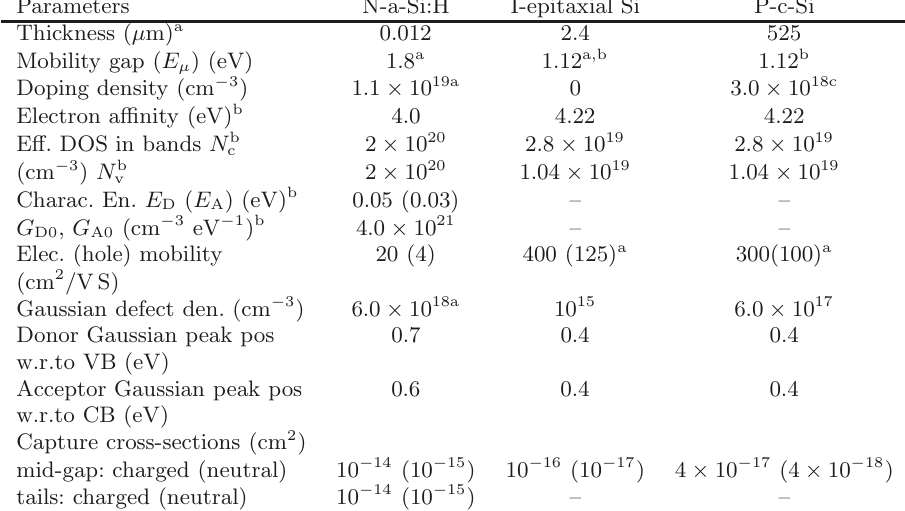
Table 2. The input parameters used to model the 2.4 μ m epi-Si layer cell. Note that the quantities marked with superscript “a” have been measured, those marked with superscript “b” have been taken from the literature, and that marked with superscript “c”, supplied by the manufacturer. The other parameters and the interface defect densities have been extracted by simulation. In this case (2.4 μ m cell), the defect density at the top N-a-Si:H/I-epi-Si interface is 10 11 cm − 2 , while that at the rear I-epi- Si/P + -c-Si interface is 10 12 cm − 2 . For the case of the 1.7 μ m cell all parameters are the same as for the 2.4 μ m cell, only the N-a-Si:H layer appears to be ∼ 16 nm from modelling (as explained in the text) and the rear interface defect density is higher: 1 . 35 × 10 12 cm − 2 . However, for the 0.9 μ m cell the defect density at both interfaces of the epi-Si layer had to be equal to 10 12 cm − 2 and the volume defect density 1 . 2 × 10 16 cm − 3 . The charged and neutral capture cross-sections ( σ ) of these defect states, have been assumed to be one order of magnitude higher than the corresponding σ ’s inside the volume of epi-Si for all cases, while a 0.5 μ m region adjacent to the top DL is assumed to have σ ’s intermediate between the two and a defect density twice that in the rest of the